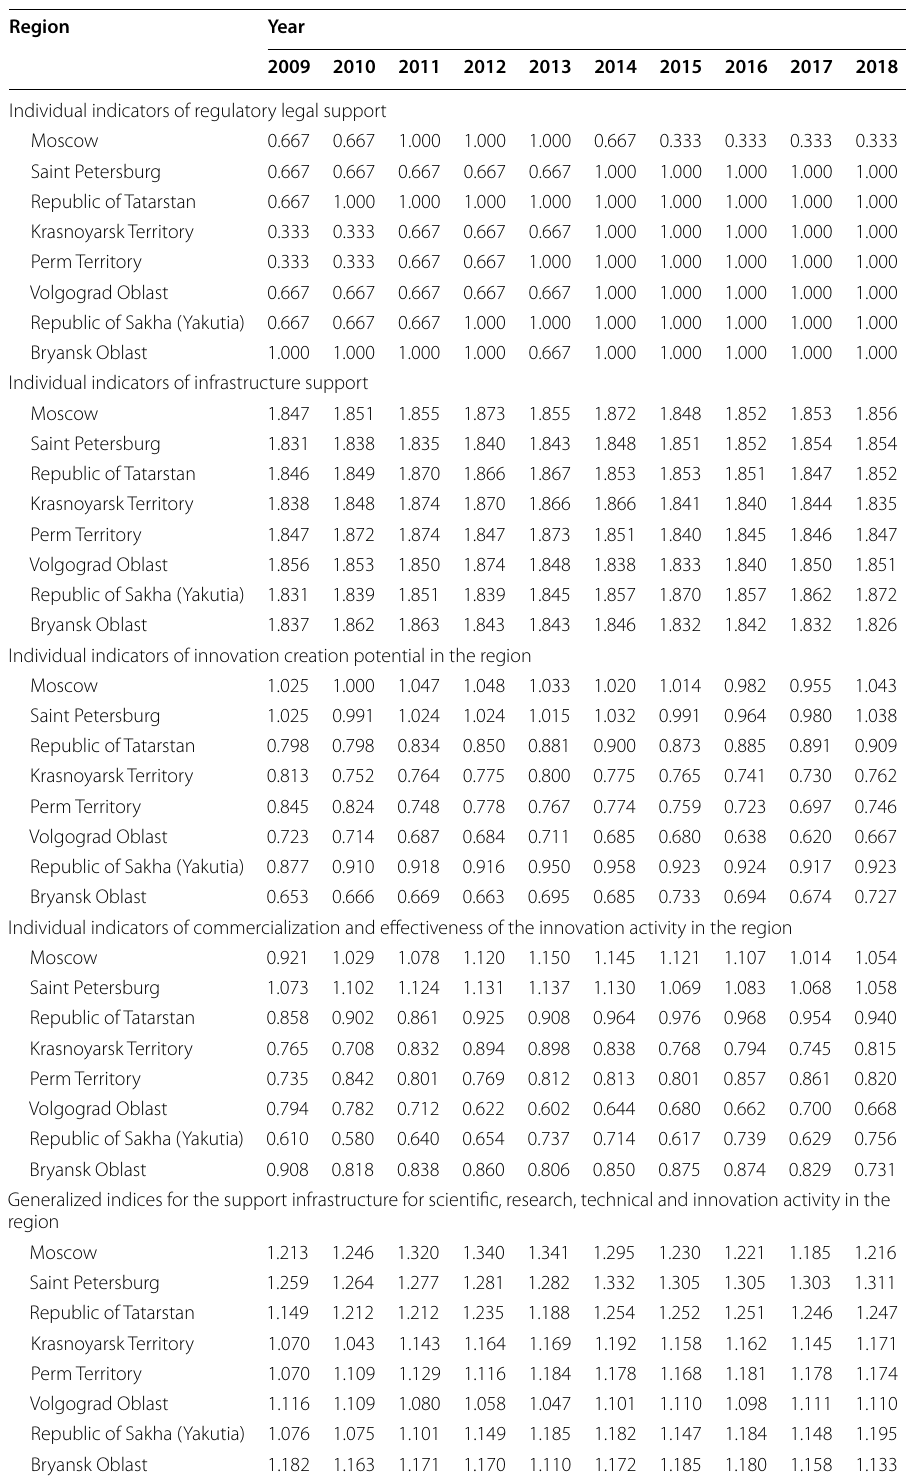
Table 3 Computation of the parameters for evaluating the support infrastructure for scientific, research, technical and innovation activity in the region by differentiated aspects